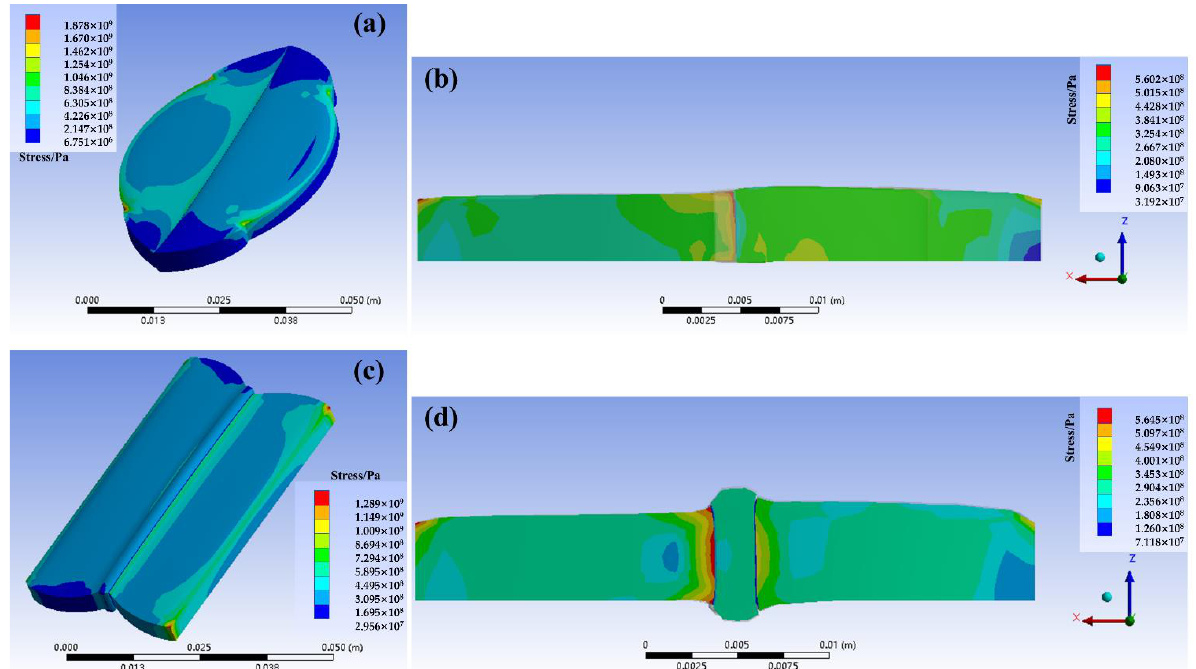
Figure 12. Specimen C 1 ( a ) Residual stress distribution, ( b ) Cross − sectional residual stress distribu- tion, and specimen V 1 , ( c ) Residual stress distribution, ( d ) Cross − sectional residual stress distribution.